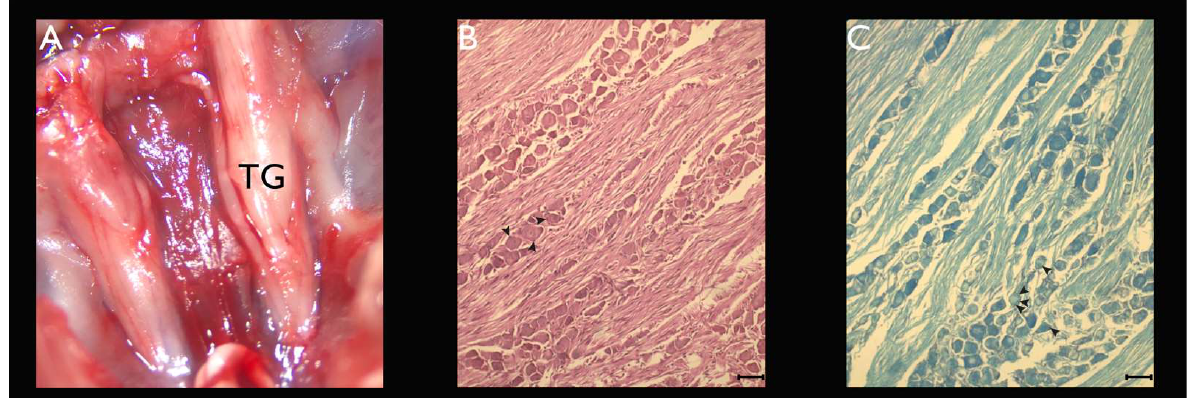
Figure 1. Dissection of the TG and histological characterization of TGCs. ( A ) Macroscopic aspect of the right and left TGs after the dissection of the skullcap, the skin (along with the subcutaneous tissue), and the brain (superior view). ( B ) Optical microscopy of a TG section stained with H&E, captured under 40× magnification. ( C ) Optical microscopy of a TG section stained with LFB, captured under 40× magnification. Arrowheads ( B , C ) represent SGCs. Scale bars ( B , C ) represent 100 µm.